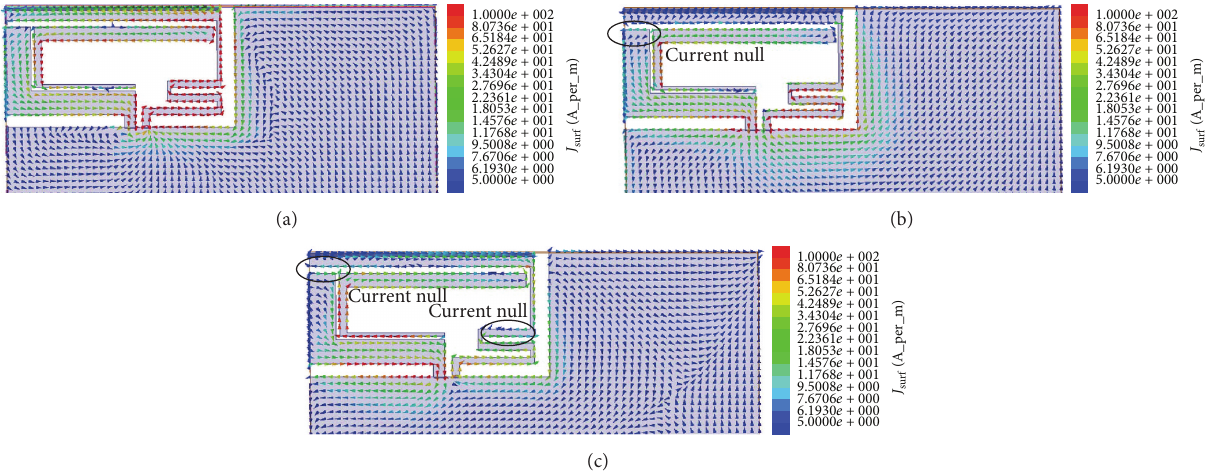
Figure 6: The simulation current distribution of the antenna: (a) 860 MHz; (b) 1620 MHz; (c) 2620